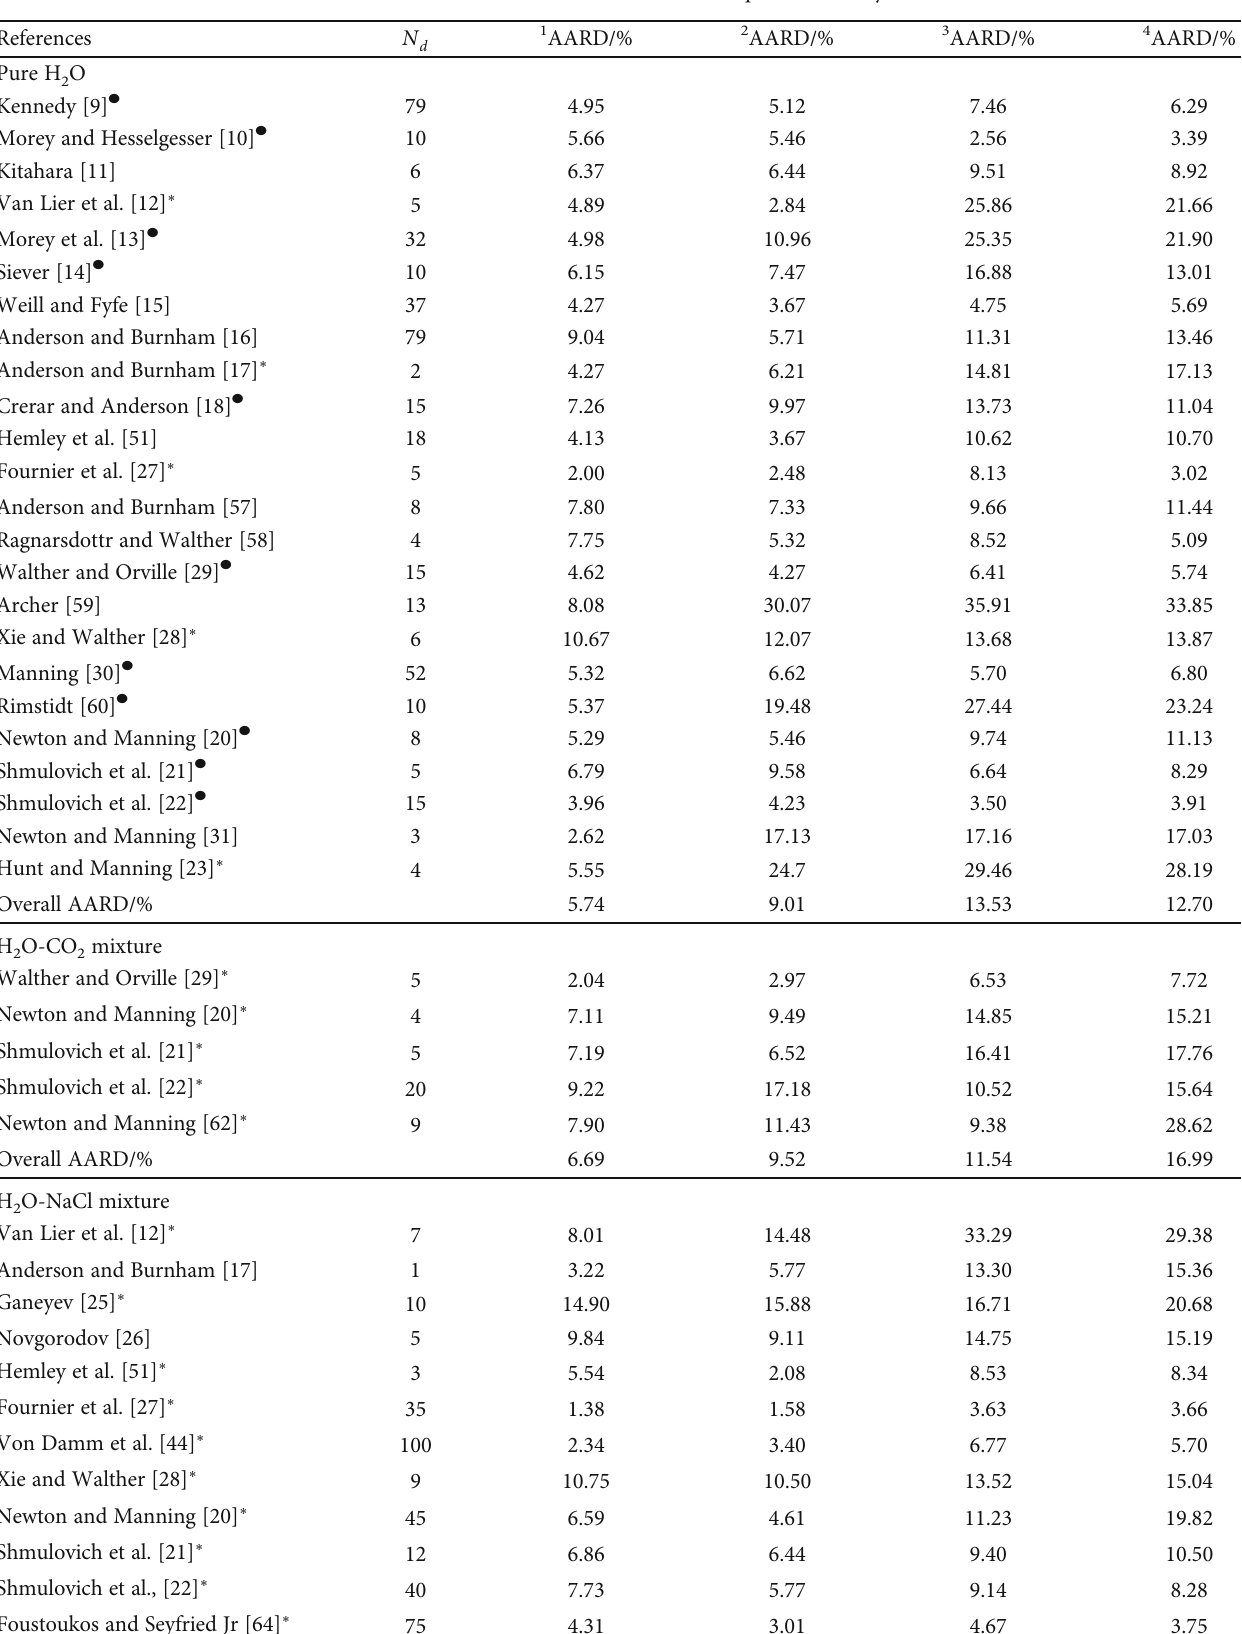
Table 3: Deviations of calculated values on quartz